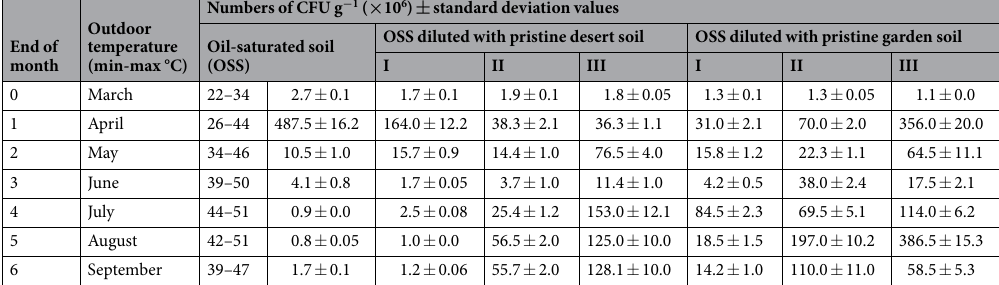
Table 2. Numbers of CFU of hydrocarbonoclastic bacteria in oil-saturated desert soil (OSS) and OSS diluted with pristine desert and garden soils. I, II and III; 1 kg OSS mixed with 0.25, 0.50 and 0.75 kg pristine soil,